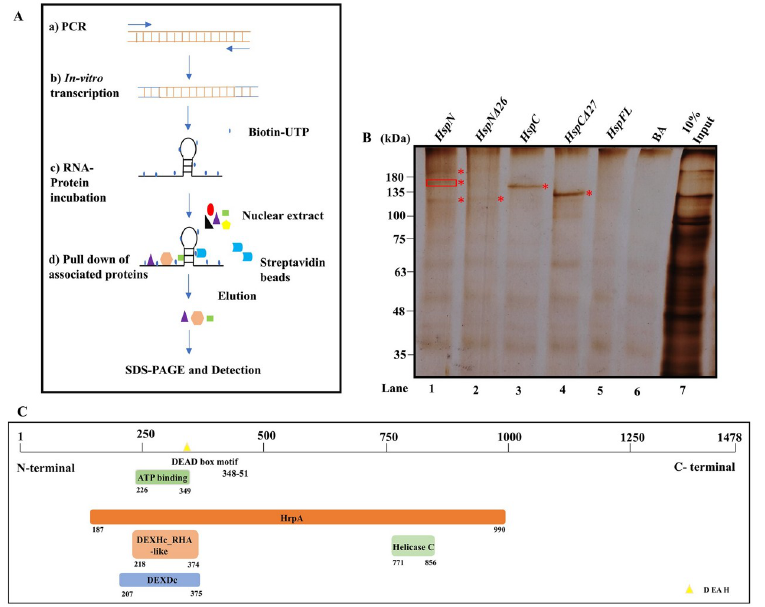
Fig 1. DEAD box RNA helicase interacts with HspN and may facilitate base pairing interaction with HspC complementary sequence. A) Schematic representation of RNA-protein pulldown experiment. B) Silver stained 8% SDS-PAGE showing specific nuclear proteins pulled—down with biotinylated pre-mRNAs- HspN, HspN Δ 26, HspC, HspC Δ 27 (Lanes 1–4). Biotinylated FL Hsp90 and bead alone (BA) in lanes 5 and 6 serve as negative controls. 10% input (lane 7) shows proteins in the nuclear extract. Unique bands obtained after the RNA-Protein pull down assay, marked in the Figure, were cut, and processed further for mass spectrometric identification of RNA binding proteins. ATP dependent RNA helicase DHR1 was identified from the middle intense band highlighted explicitly using a box, among the three intense bands pulled down with wild type HspN in Lane 1. Other unique proteins pulled down with HspN (lane 1) in the other two bands, proteins pulled down with HspN Δ 26 , HspC and HspC Δ 27 are subject matter for future research. C) Schematic representation describing the different domains of Giardia RNA helicase identified to be interacting with HspN pre-mRNA. The protein-protein blast with pre-mRNA splicing factor, ATP dependent RNA helicase- PRP16 of S . pombe revealed the presence of DEAD/H box helicase motif between 348–351 aa which was previously not